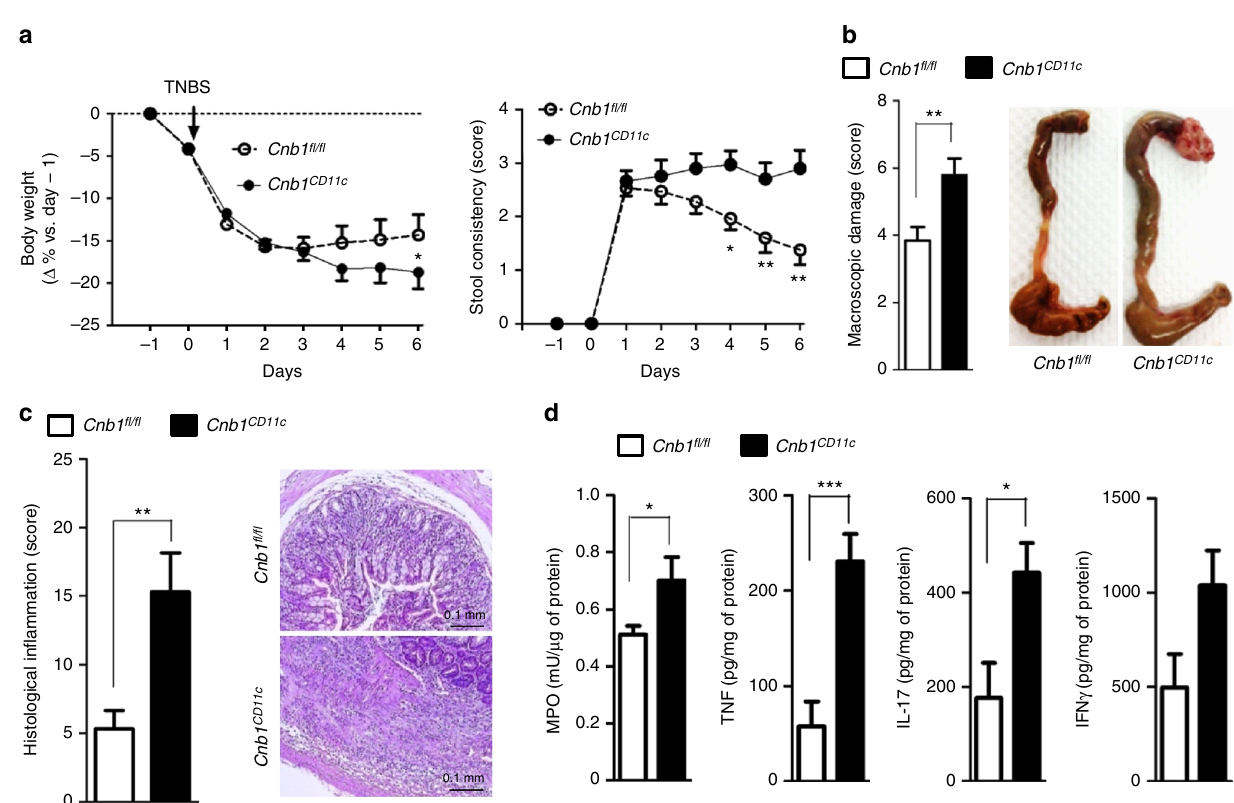
Fig. 4 Exacerbation of acute and chronic colitis in Cnb1 CD11c mice. a Severity of TNBS-induced colitis evaluated according to weight loss (left panel) and stool consistency (right panel) in Cnb1 CD11c and Cnb1 fl / fl mice. b Macroscopic index (left) and overt anatomy of the colon (right) and c histological in fl ammation score for colons of Cnb1 CD11c and Cnb1 fl / fl mice after TNBS administration. Representative H&E-stained colon sections showing in fi ltrating leukocytes (×10 magni fi cation, scale bar 0.1 mm). d Levels of in fl ammatory markers (MPO, TNF, IL-17, and IFN γ ) in total colon homogenates from Cnb1 CD11c and Cnb1 fl / fl mice. All data represent the means ± standard error of two experiments ( n = 6 – 7 mice/group per experiment). * P < 0.05, *** P < 0.001. TNBS trinitrobenzenesulfonic acid, MPO